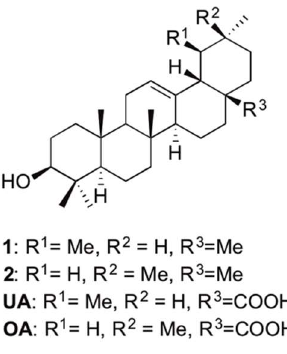
Figure 1. Basic structure of pentacyclic triterpenes of the amyrin family.